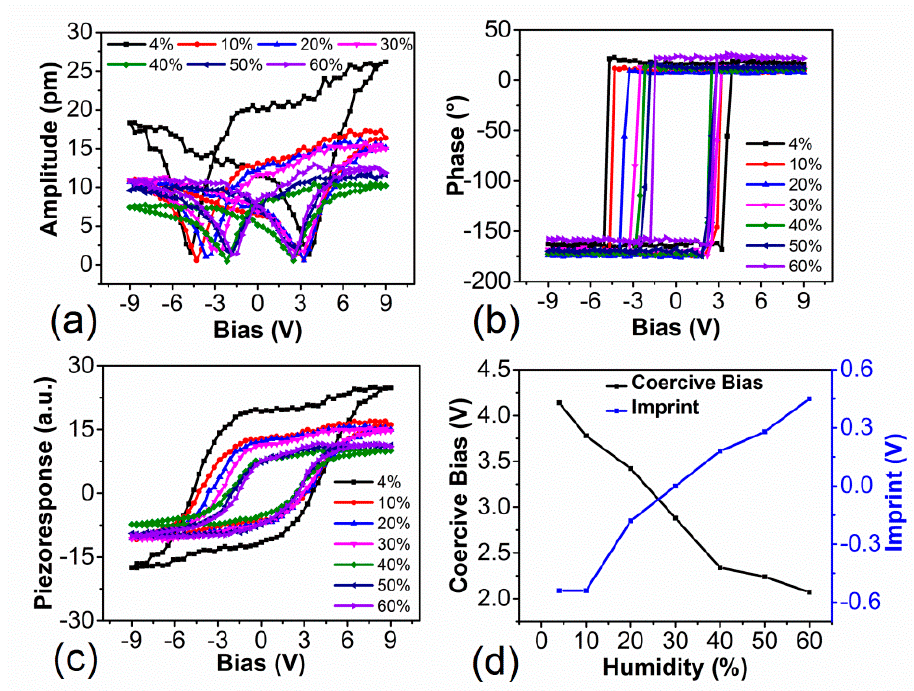
Figure 3. Hysteresis loops of a PZN − 9%PT single crystal with relative humidities varying from 4% to 60%: ( a ) amplitude loop, ( b ) phase loop, and ( c ) calculated piezoresponse loop. ( d ) Coercive bias and imprint as a function of the humidity.